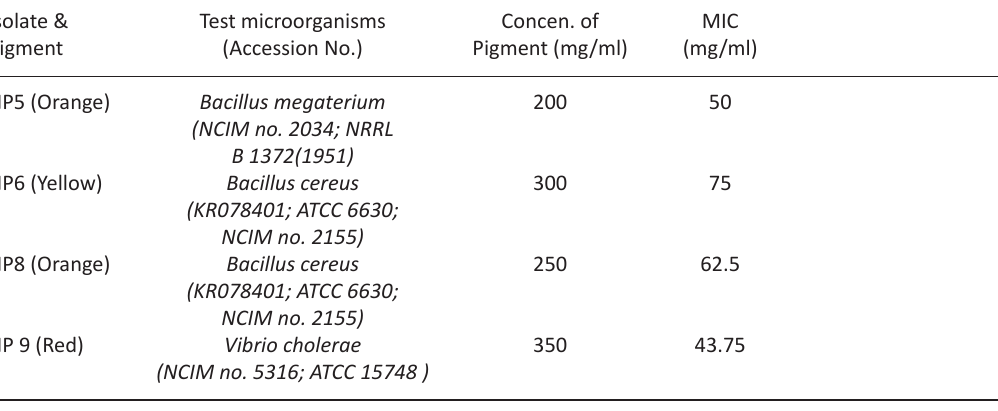
Table 3. Minimum inhibitory concentration (MIC) of bacterial pigments against different test microorganisms. Isolate & Test microorganisms Concen.